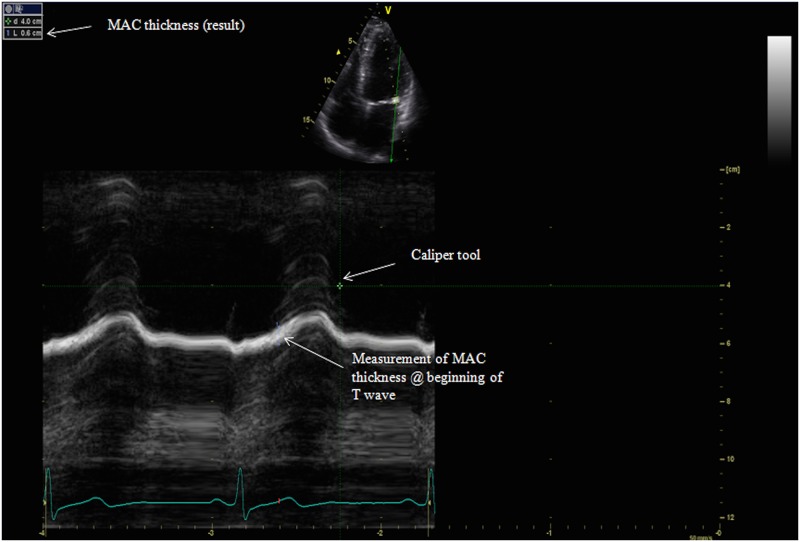
M-mode measurement of MAC in the apical four chamber view.MAC—Mitral annular calcification; cm—centimeters. Abbreviations: Mitral Annular Calcification (MAC).